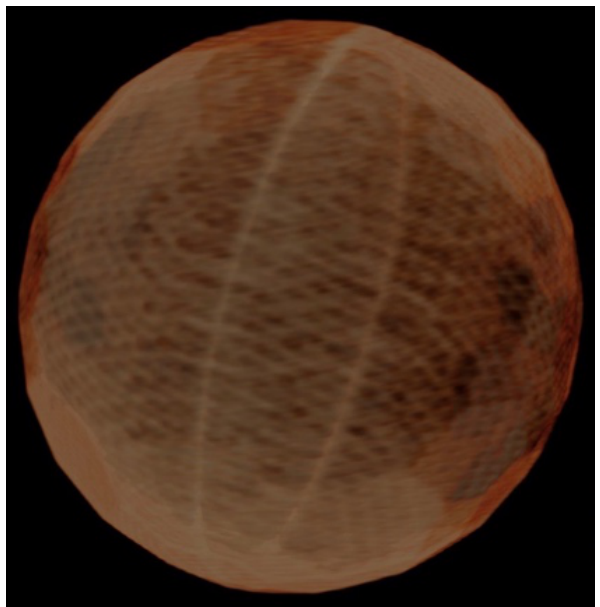
Figure 7. Computed tomography (CT) scan reconstruction of the PLA (polylactic) model. Interface and honeycomb internal struc- ture. Diameter 65mm.